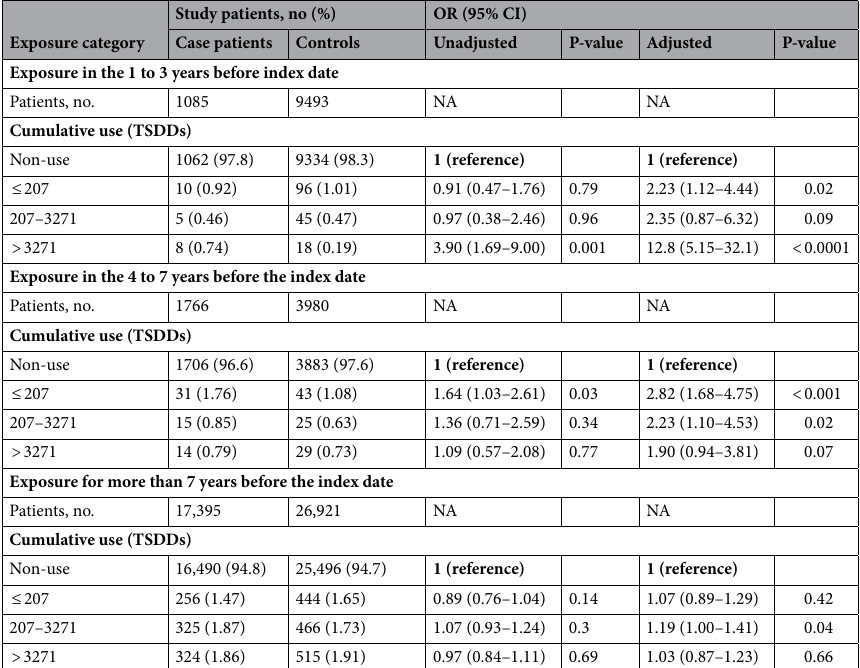
Table 3. Risk of dementia associated with cumulative use of bladder antimuscarinic drugs among study patients. OR odds ratio. *Adjusted for age, sex, all comorbidities, all medications, and other anticholinergic drugs.